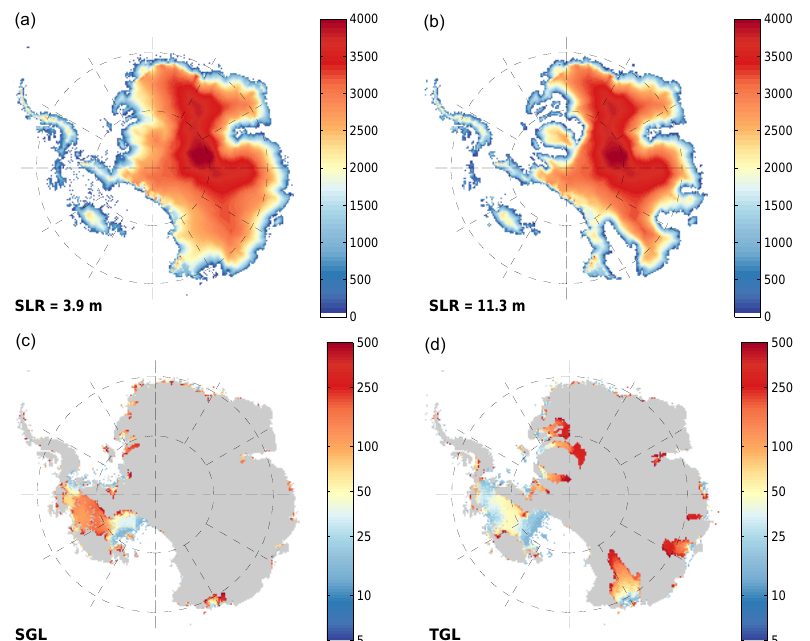
Figure 9. (a, b) Grounded ice sheet surface elevation (ma.s.l.) 500 years after applying melt rates of Cornford et al. (2016). (c, d) Grounding- line position in time according to the same experiment (colour scale is non-linear and represents time in years) for the Weertman sliding law with SGL condition (a, c) and Coulomb friction law with TGL